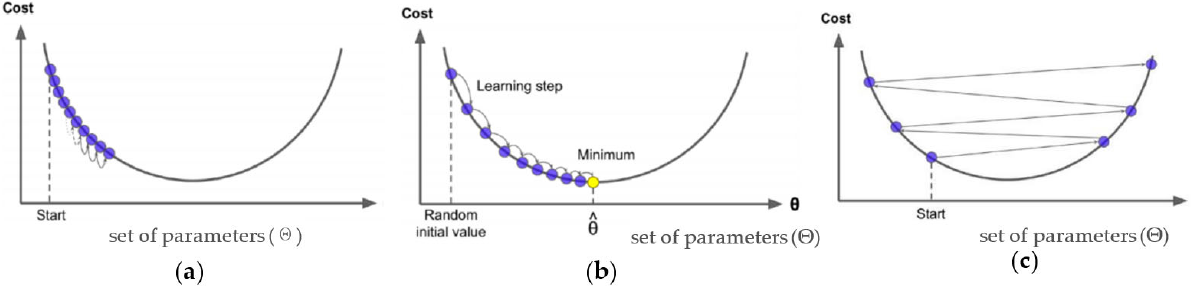
Figure 3. ( a ) Too small learning rate λ 29 ; ( b ) gradient descent in GBM function 29 ; ( c ) too large learning rate λ 29.